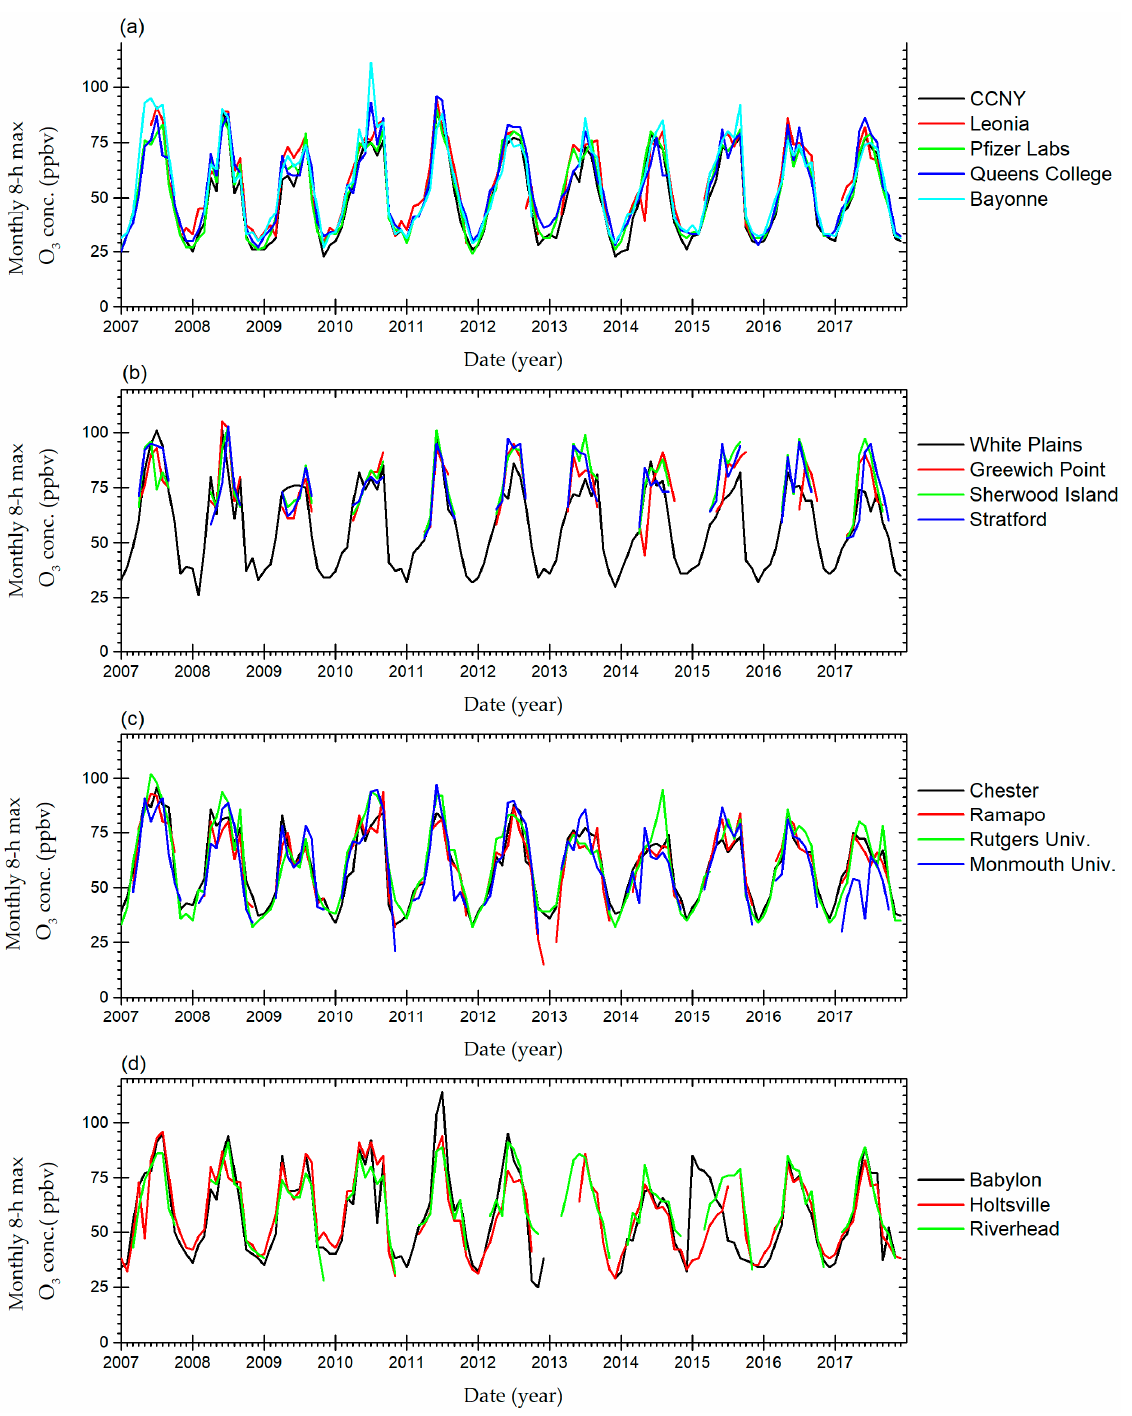
Figure 2. Times series of monthly 8-h max O 3 (in ppbv) at ( a ) urban sites; ( b ) peri-urban sites north of NYC and in Connecticut; ( c ) peri-urban sites in NJ and ( d ) peri-urban sites in Long Island.